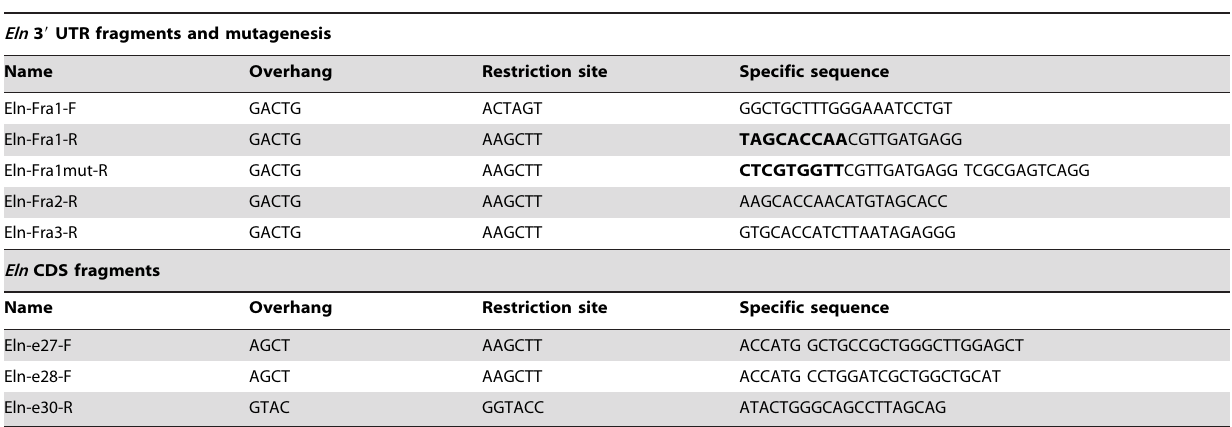
Table 2. Sequences of the primers used for reporter